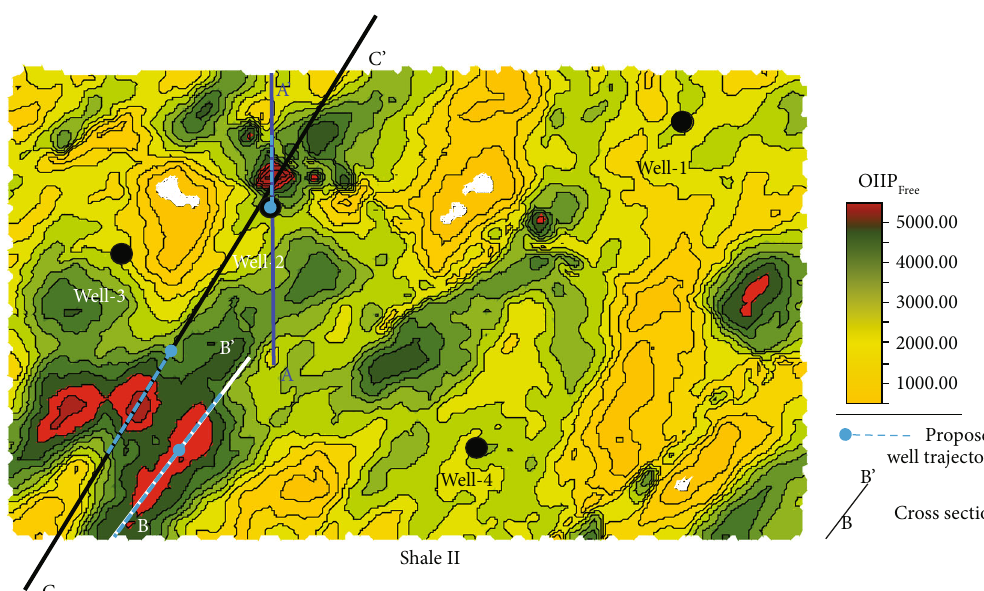
Figure 9: Average map of free oil-in-place estimated with the geochemical method in 3D geological model domain: calculation results obtained for each grid cell have been summed for the entire thickness of Sasino shale formation. Blue, white, and black lines mark a cross- section made through the 3D model, which is presented in the next fi